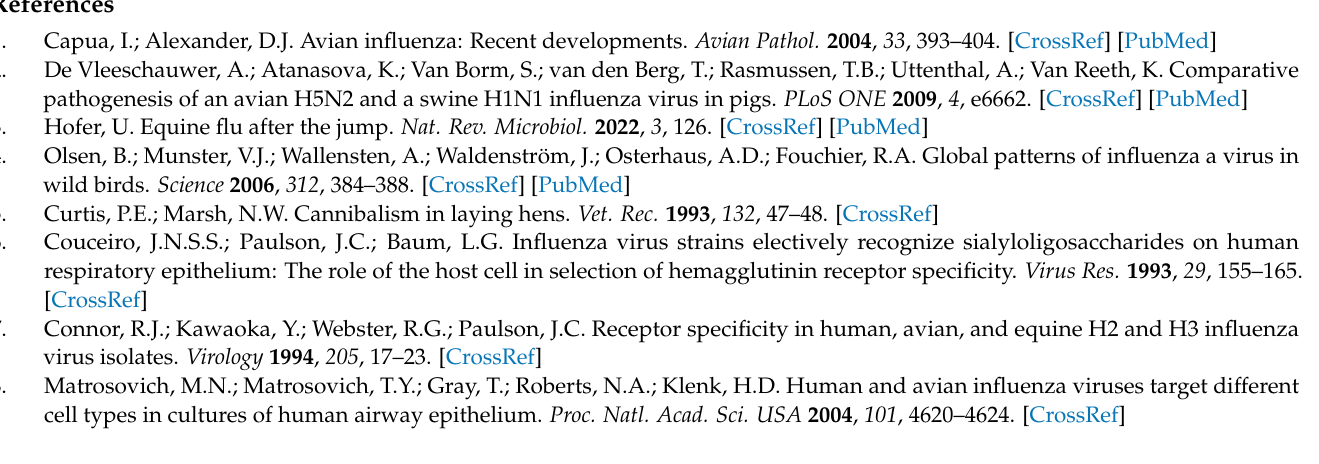
Table S2. List of viruses. Partly sequenced